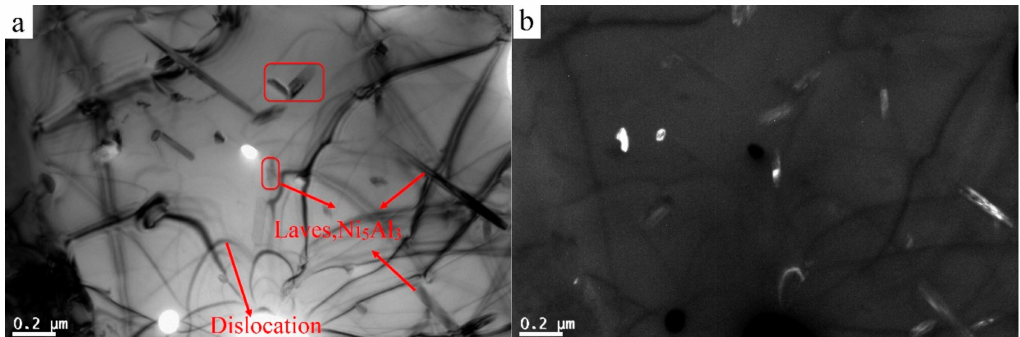
Figure 6. The bright field image ( a ) and dark field image ( b ) of TEM micrographs of the β phase with aging for 20,000 h at 650 ◦ C.